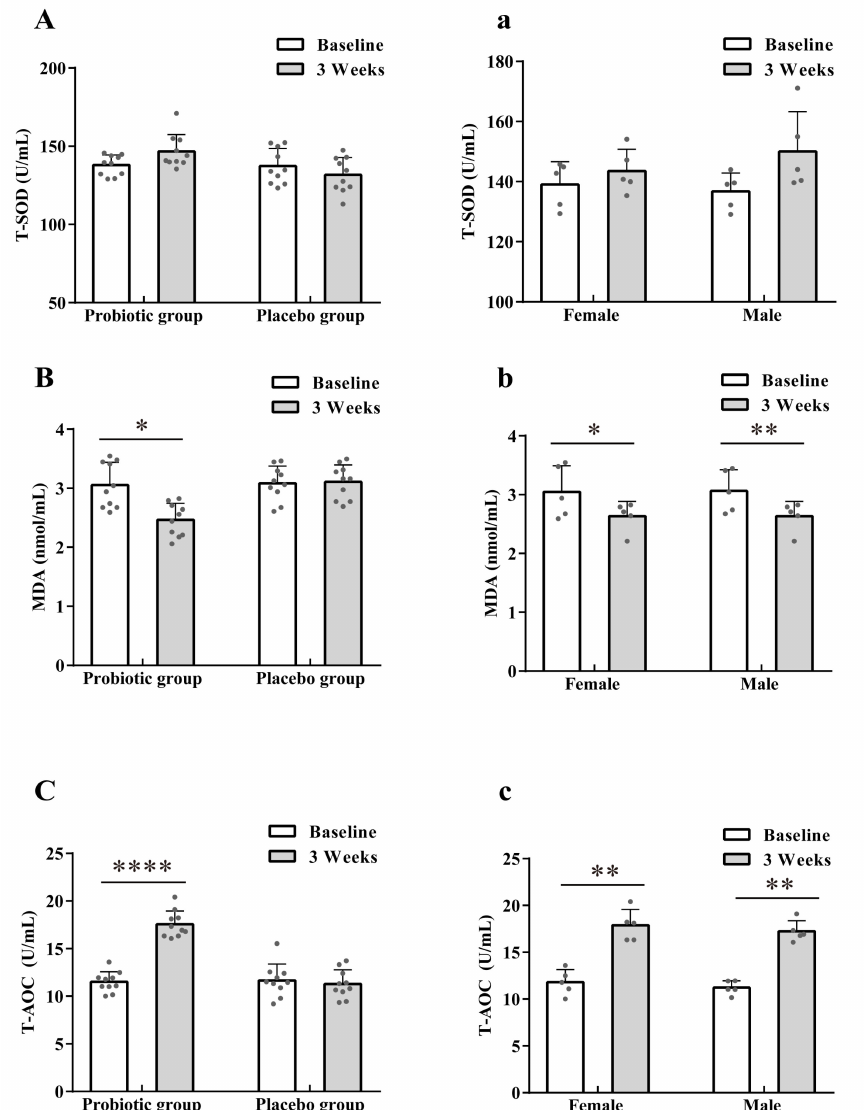
Figure 2. Effects of LTL1879 on total superoxide dismutase (T-SOD) activity, malondialdehyde (MDA) levels, and total antioxidant capacity (T-AOC) activity in serum of volunteers. ( A ) Serum T-SOD activity of volunteers. ( B ) Serum MDA levels of volunteers. ( C ) Serum T-AOC activity of volunteers. ( a ) Serum T-SOD activity of volunteers in probiotics group. ( b ) Serum MDA levels of volunteers in probiotics group. ( c ) Serum T-AOC activity of volunteers in the probiotics group. Data are shown as means standard deviations (SD). Asterisks indicate significant differences (paired t -test, * p < 0.05, ** p < 0.01, **** p < 0.0001). n = 10 or n = 5 volunteers per